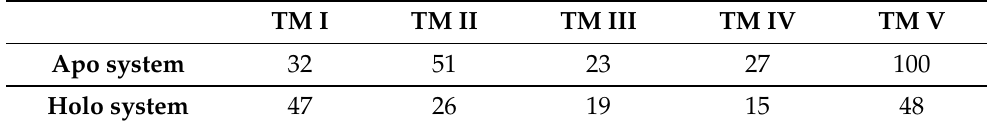
Table 1. The percentage (%) of the simulation time during which the individual transmembrane helices (TM I–TM V) bind the cholesterol molecule(s). The total simulation time is 1 µ s.